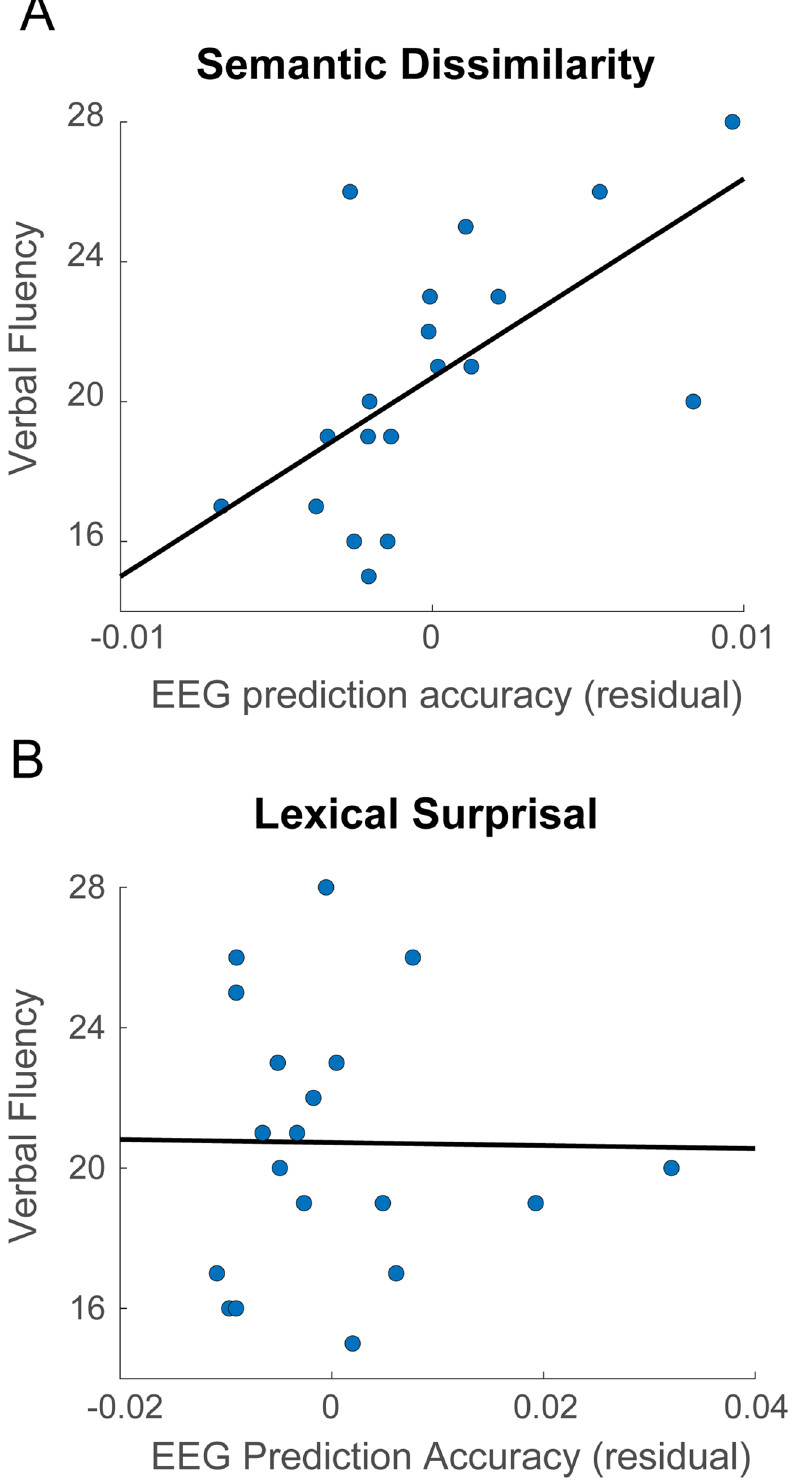
Figure 3. ( A ) Within the older subjects, semantic category fluency was positively correlated with the semantic dissimilarity model performance when controlling for age (R = 0.63 p = 0.005). ( B ) In contrast, semantic category fluency was uncorrelated with the lexical surprisal model performance when controlling for age (R = − 0.04 p =